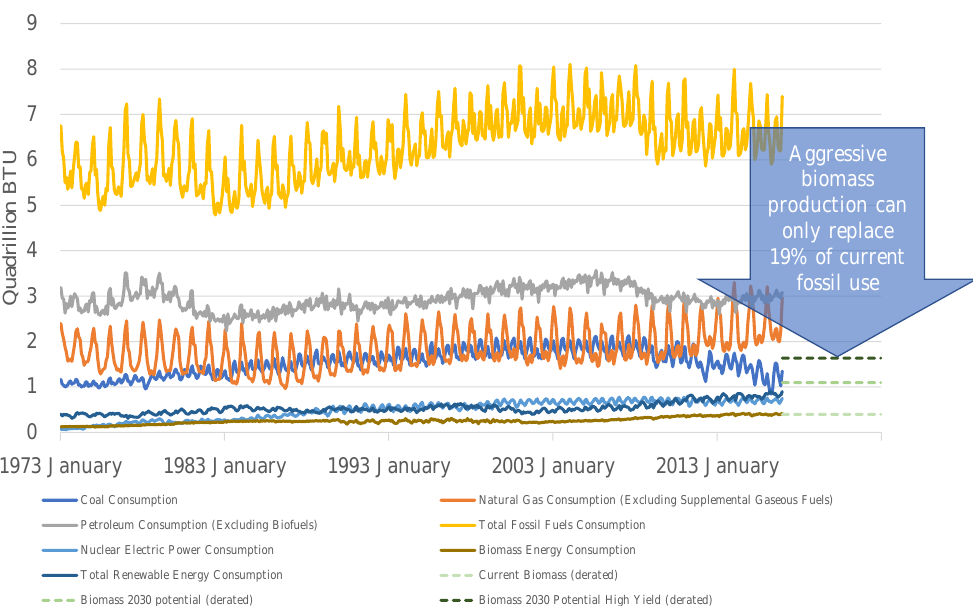
Figure 3. Primary energy consumption in the US 1973–2016 and the potential for biomass.